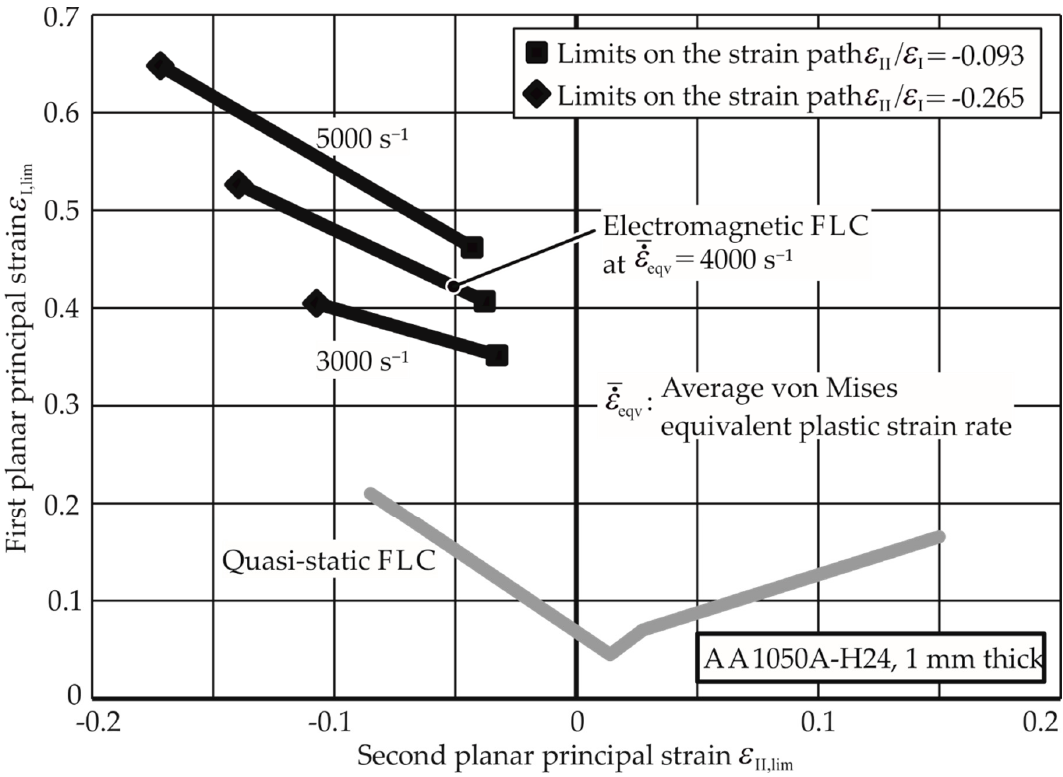
Figure 16. Electromagnetic forming limit curves (FLC) of AA-1050a-H2410 at different strain rates. The quasi-static FLC is given for comparison.